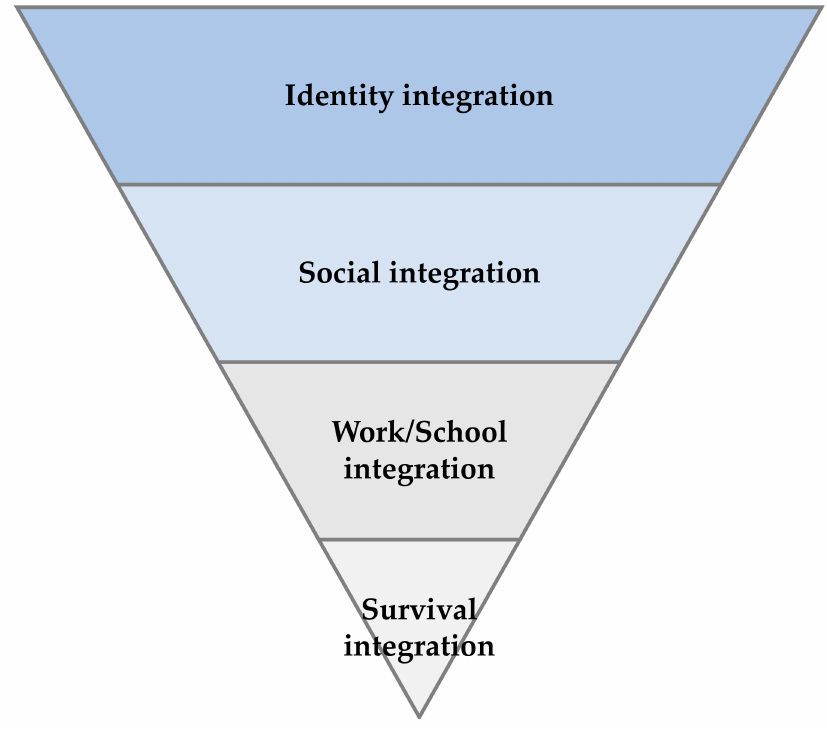
Figure 2. Integration process pyramid. Source: Moreno Fern á ndez (2009, p.